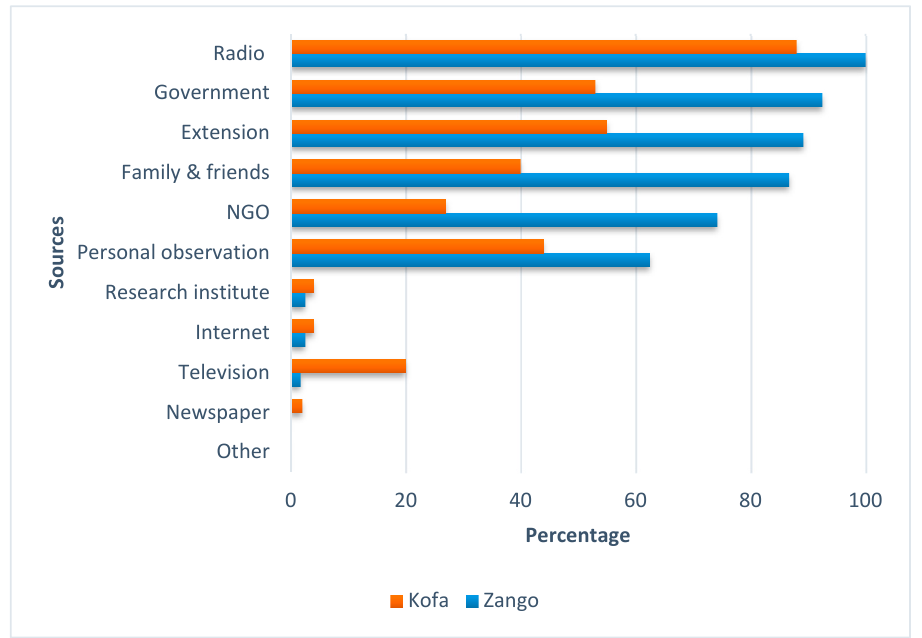
Figure 2. Sources of climate information in Zango (n = 120) and Kofa (n = 100) in terms of the most utilized sources. NGO—Non-Governmental Organisation.